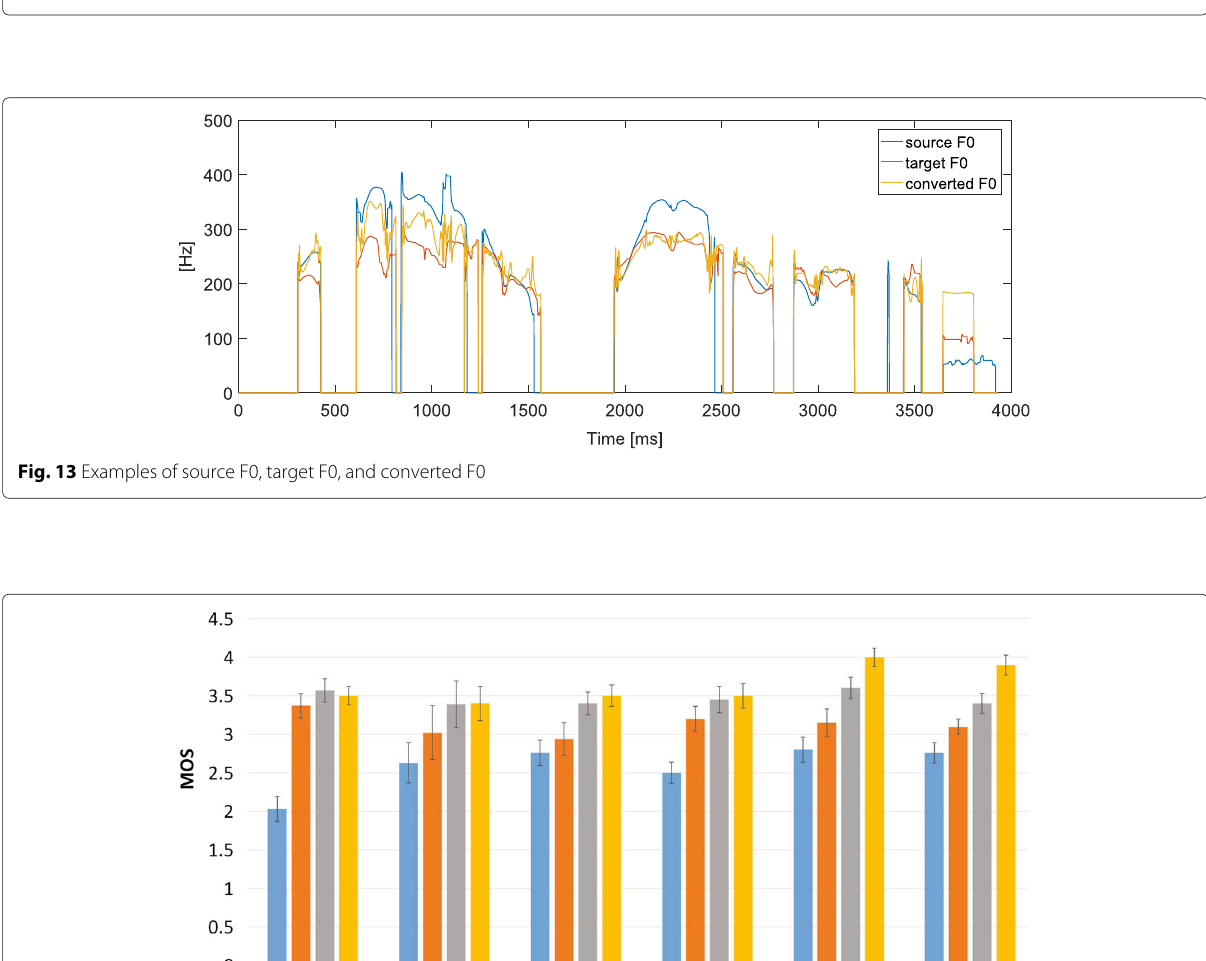
Fig. 12 Root mean-squared error evaluation of F0 features conversion from neutral to emotional voices